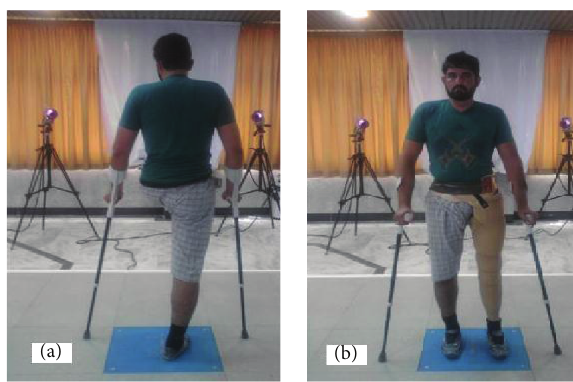
Figure 1: (a) Subject with hemipelvectomy amputation without prosthesis and (b) the subject while standing with a Canadian